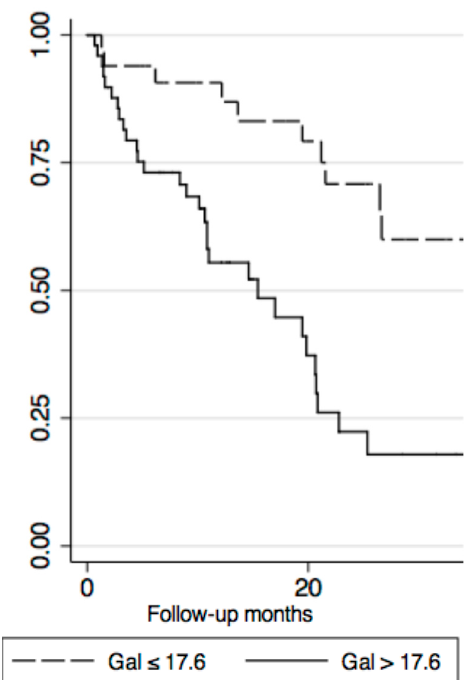
Figure 1. Kaplan–Meier curve with Galectin-3 > 17.6 ng/mL (log-rank 13.22; p = 0.0003).